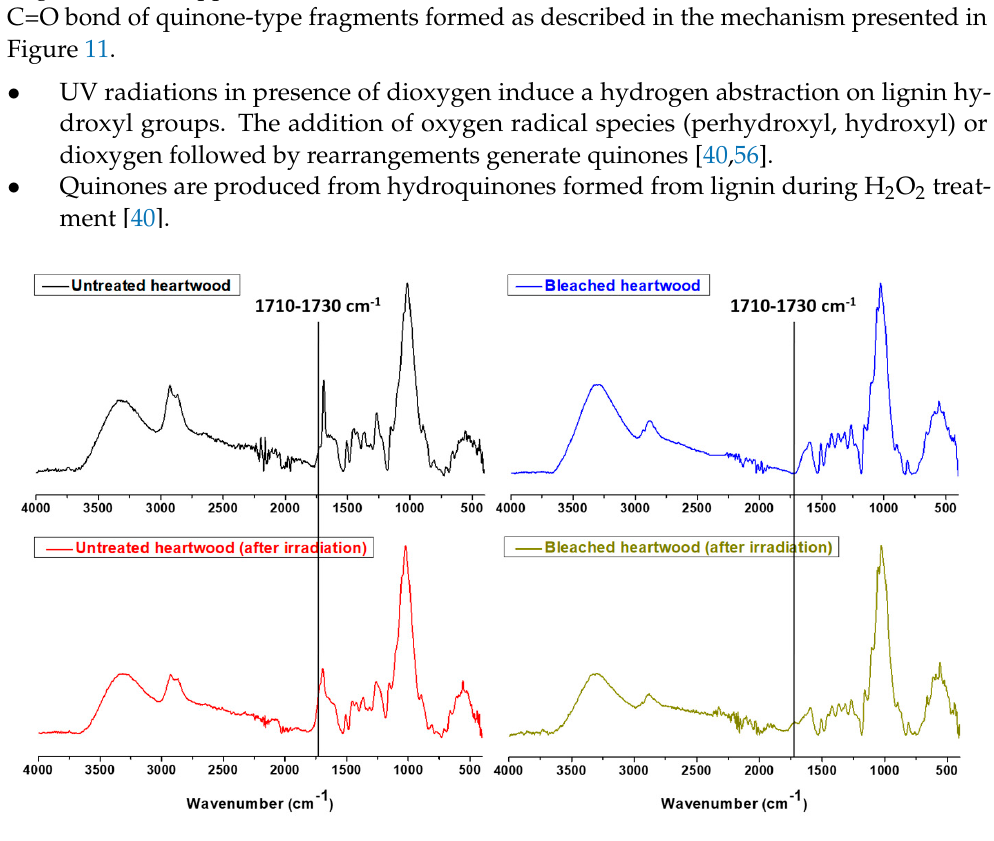
Figure 11. Quinone derivatives formation under the influence of UV irradiation ( a ) and evolution of hydroquinone formed from H 2 O 2 treatment into quinone ( b ) [40,56].